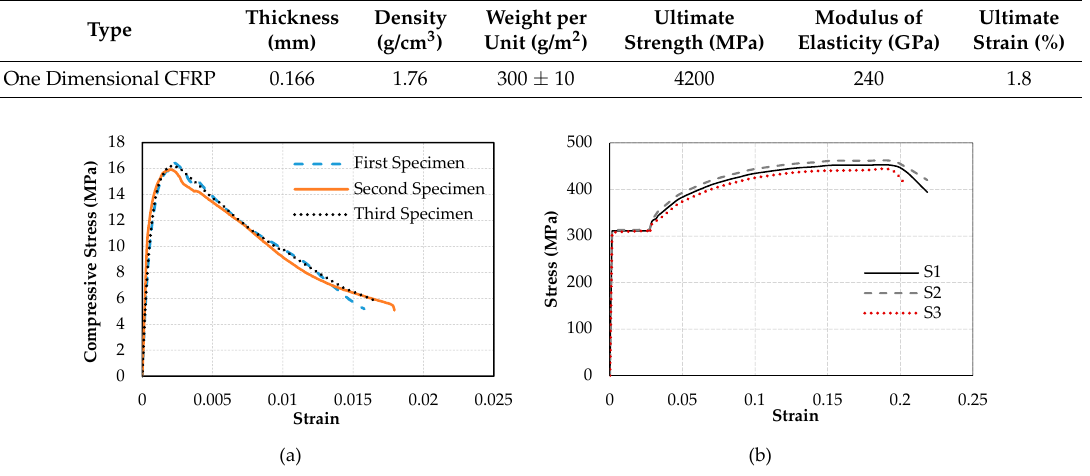
Figure 1. ( a ) Concrete stress-strain relationships; ( b ) rebar stress-strain relationships. S1, S2 and S3 are specimens with 14 mm-diameter longitudinal bars. Table 3. Test matrix. FRP, fiber-reinforced polymer; REF, reference specimen; RET, retrofitted specimen; W, weak; N1, one layer of CFRP sheet; N2, two layers of CFRP sheets.